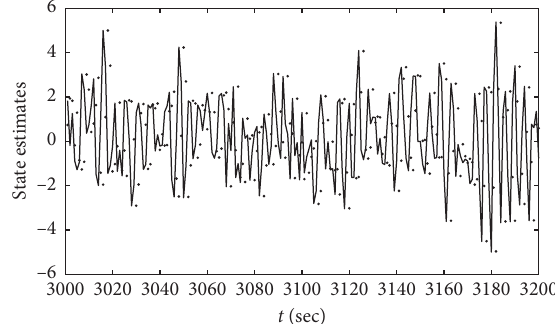
Figure 2: The parameter estimation errors δ versus t with σ 2 � 1 . 00 2 .